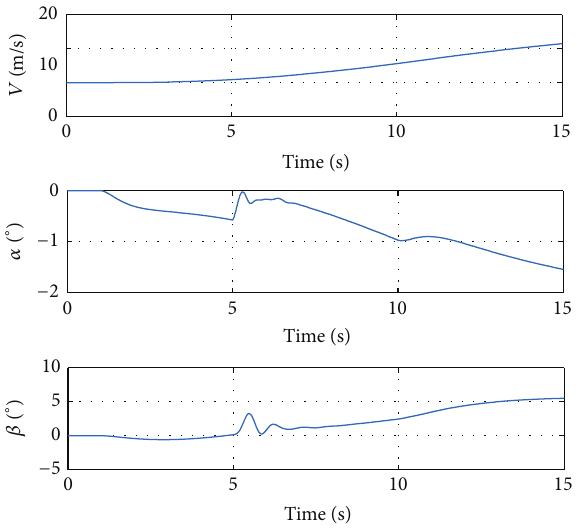
Figure 5: Response of the other states in simulation with step input signal.